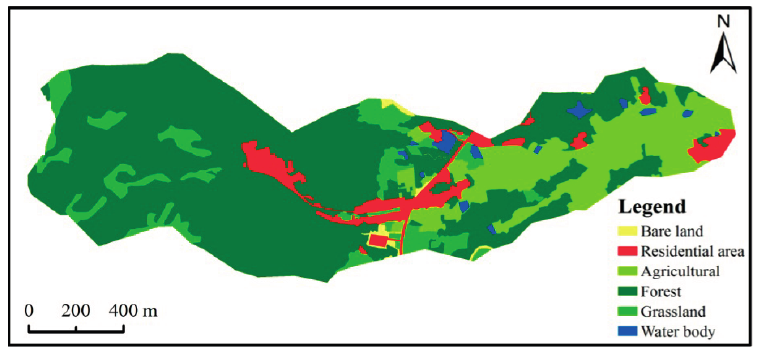
Figure 2. Land use map of the Wucun